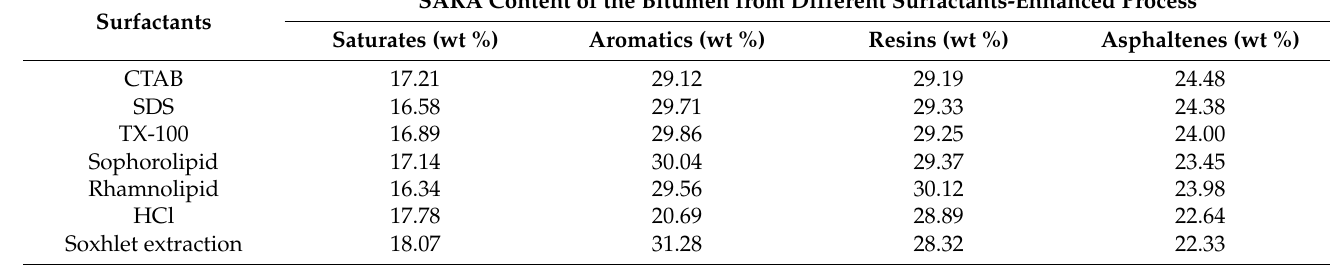
Table 2. SARA analysis of heavy oil by different surfactants enhanced reaction extraction process. SARA Content of the Bitumen from Different Surfactants-Enhanced Surfactants